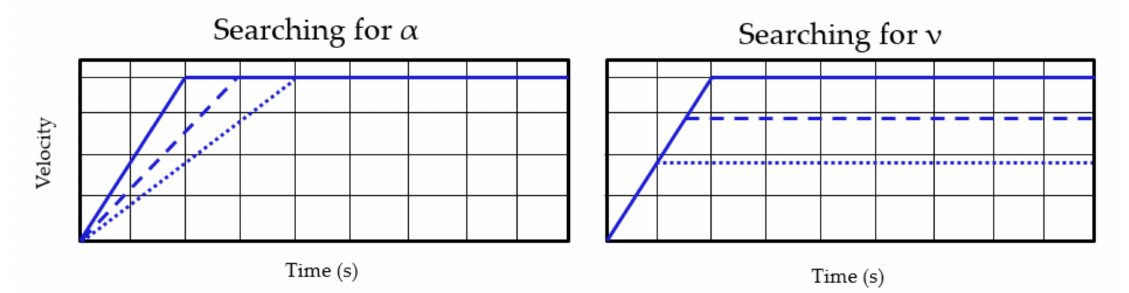
Figure A1. Grid search is done by searching every combination of α and ν . Then, we chose the combination with the best FE. This is then compared with FE made from our method.